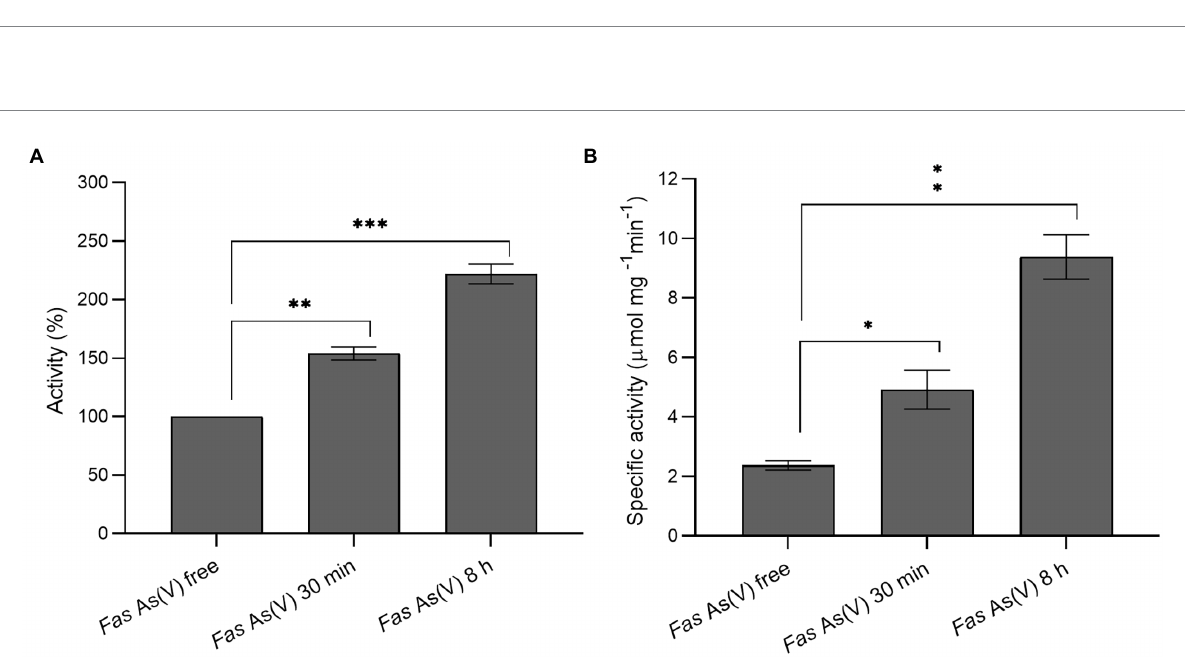
FIGURE 4 Measurement of thioredoxin and thioredoxin reductase activities. (A) Thioredoxin activity of Fas cells exposed to As(V) compared to the activity of cells grown without As(V). (B) Specific thioredoxin reductase activity of Fas before and after As(V) exposure. * p < 0.05; ** p < 0.01; *** p <